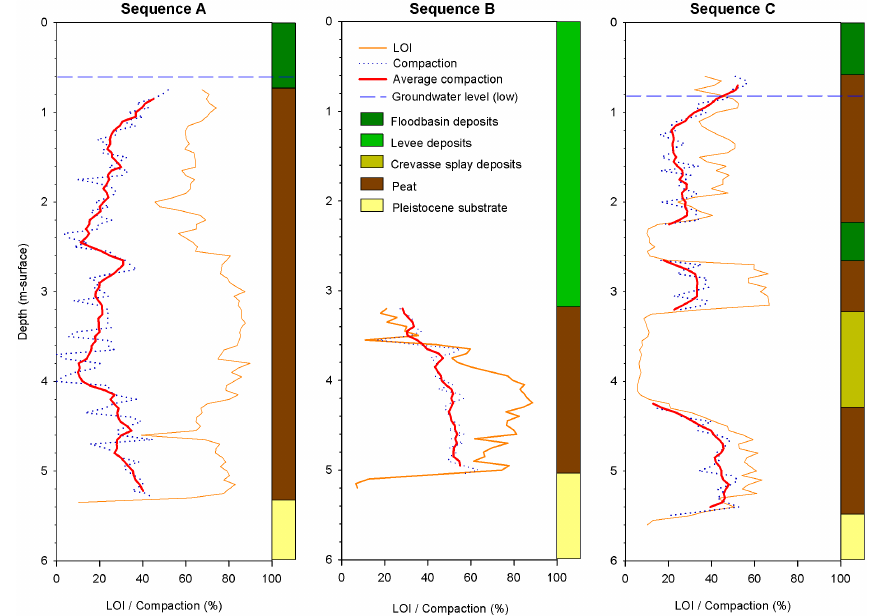
Figure 3. Lithological composition, LOI and amount of compaction of cores OR-I (sequence B), OR-II (sequence A), and CB-I (sequence C) (after van Asselen, 2011). These sequences are representative for the sequences A, B and C in Fig. 2. (cid:0) (cid:0) (cid:1) − v red = (1 × 1 × 5) 1 × 1 × h decomp